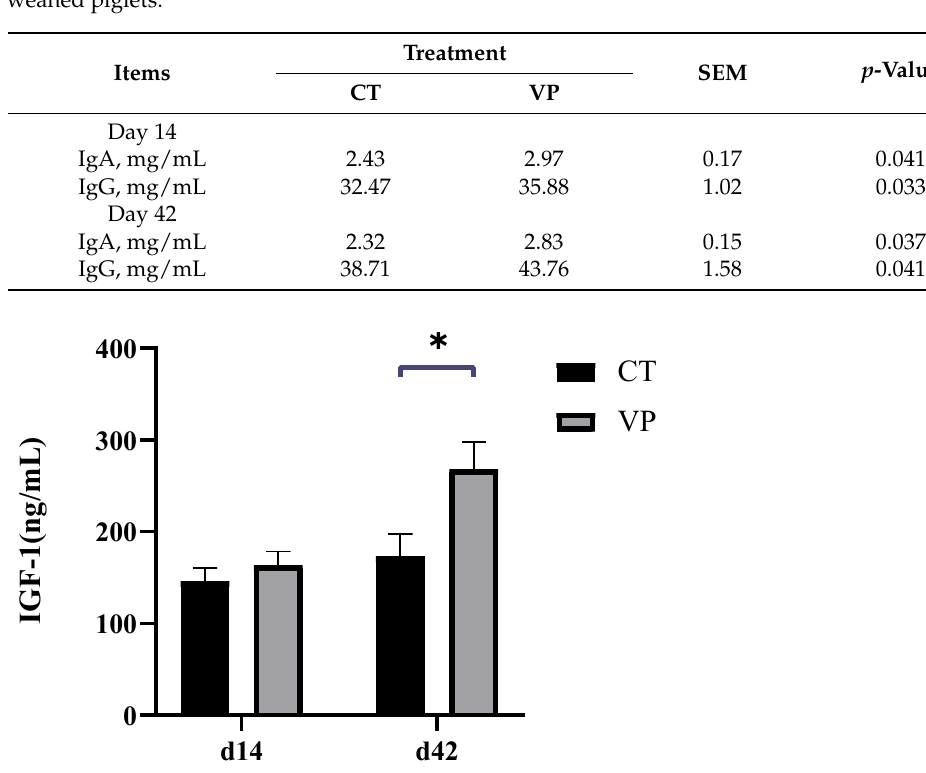
Figure 1. Effect of dietary supplementation with stimbiotics on plasma hormone levels of weaned piglets, the sign *—indicates the degree of significant difference, * p < 0.05.